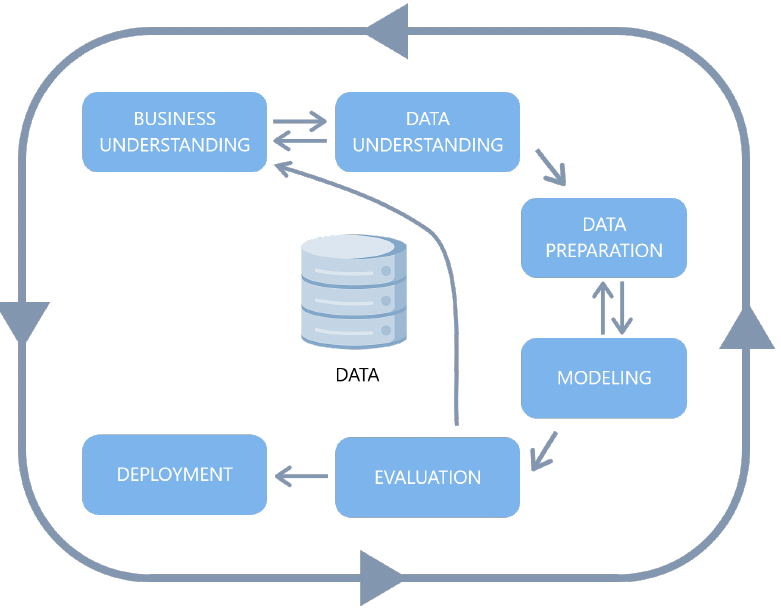
Figure 1. Stages of the CRISP-DM